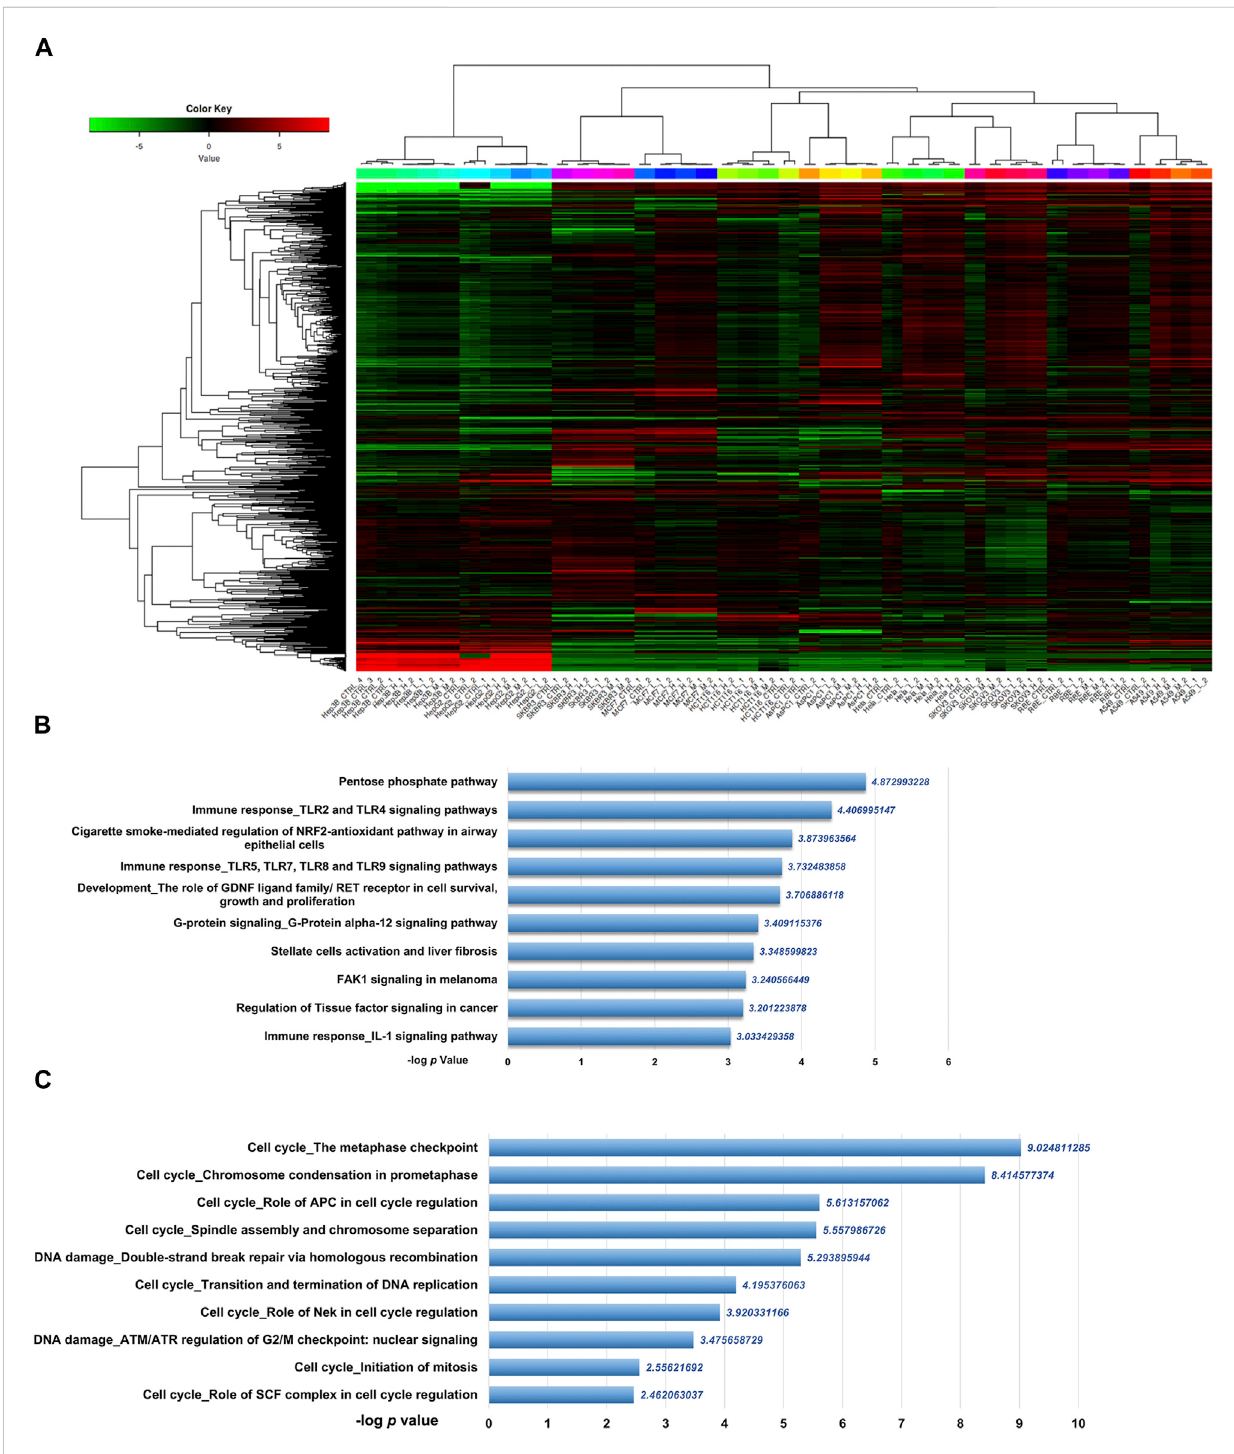
FIGURE 3 Differentially expressed genes analysis of transcriptomic data from ten cancer cell lines treated with CR. (A) Heatmap was used to show the expression pro fi les of mRNAs. L, Low dosage; M, M dosage; H, High dosage. (B) Up and (C) down DEGs functional enrichment analysis from ten cancer cell lines treated with three concentrations using